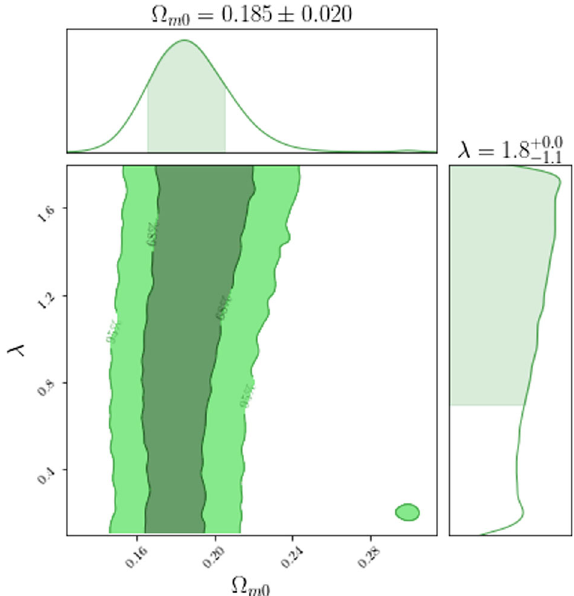
Fig. 7 MCMC simulations for the f ( R ) model with n = 2, consid- ering [ f σ 8 ] ( z ) data and the flat priors: λ − 1 ∈ [ 0 . 1 , 2 . 0 ] and Ω m 0 ∈ [ 0 . 15 , 0 . 4 ]